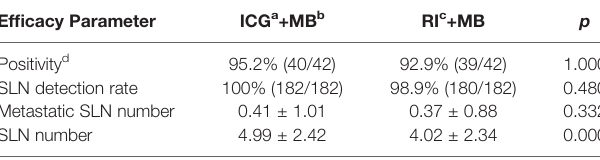
TABLE 3 | Comparison of ef fi cacies of ICG+MB and